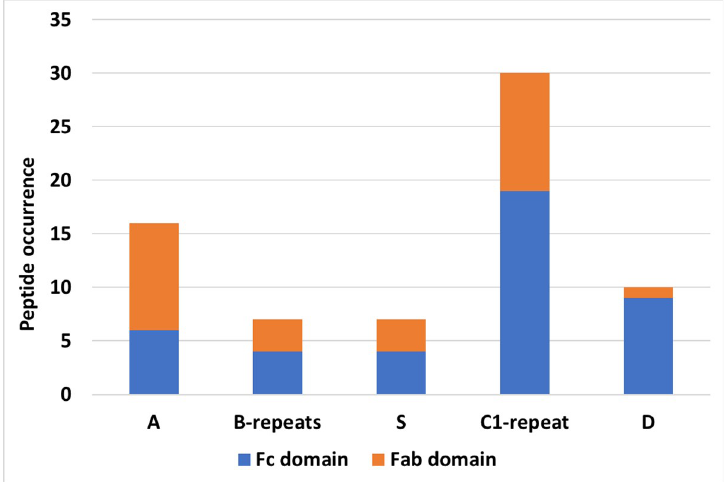
Fig 4. DDA-based peptide quantification of Fc and Fab fragments of IgG subclasses bind to different sub- domains of M1 protein. All IgG subclasses bind to the M1 protein through their Fc-domains. The S- & C1-domains and the hypervariable domain A of the M1 protein have the highest affinity for IgG subclasses. Only IgG heavy chains were considered.